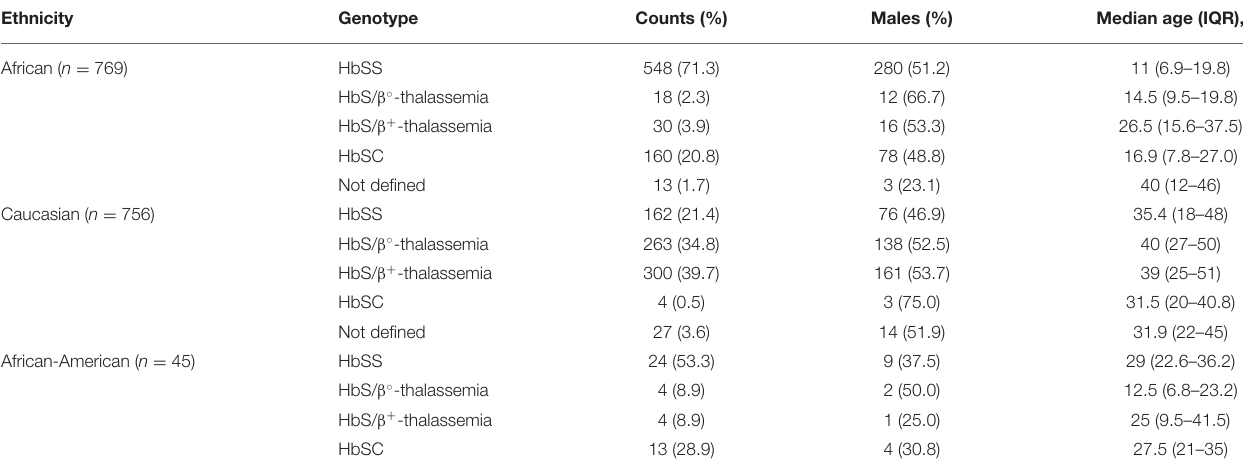
TABLE 1 | Demographic characteristics of patients with sickle cell disease